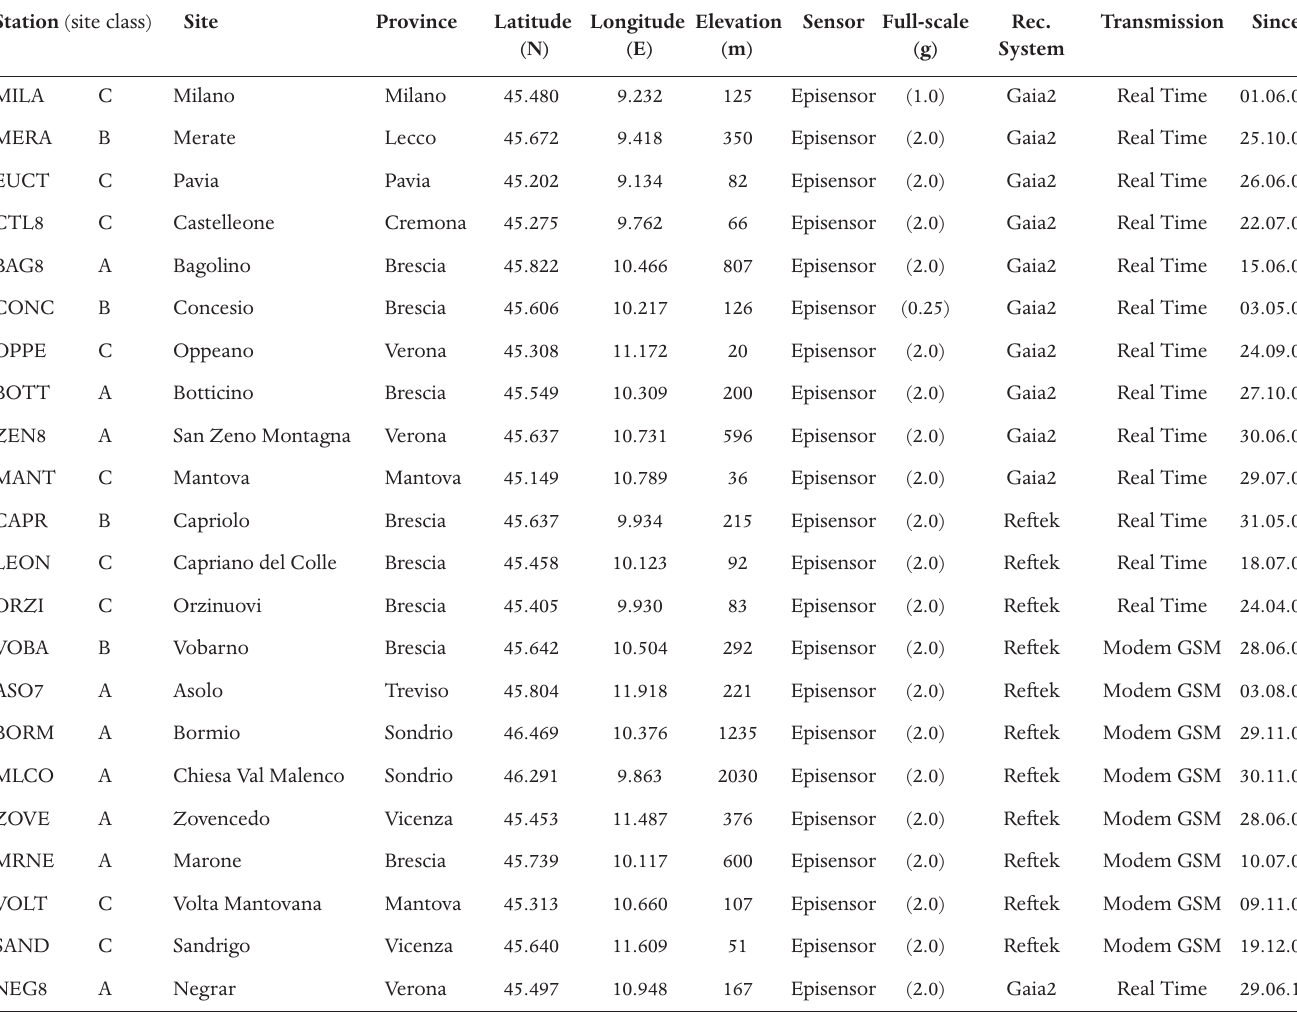
Table 1. Main features of the RAIS